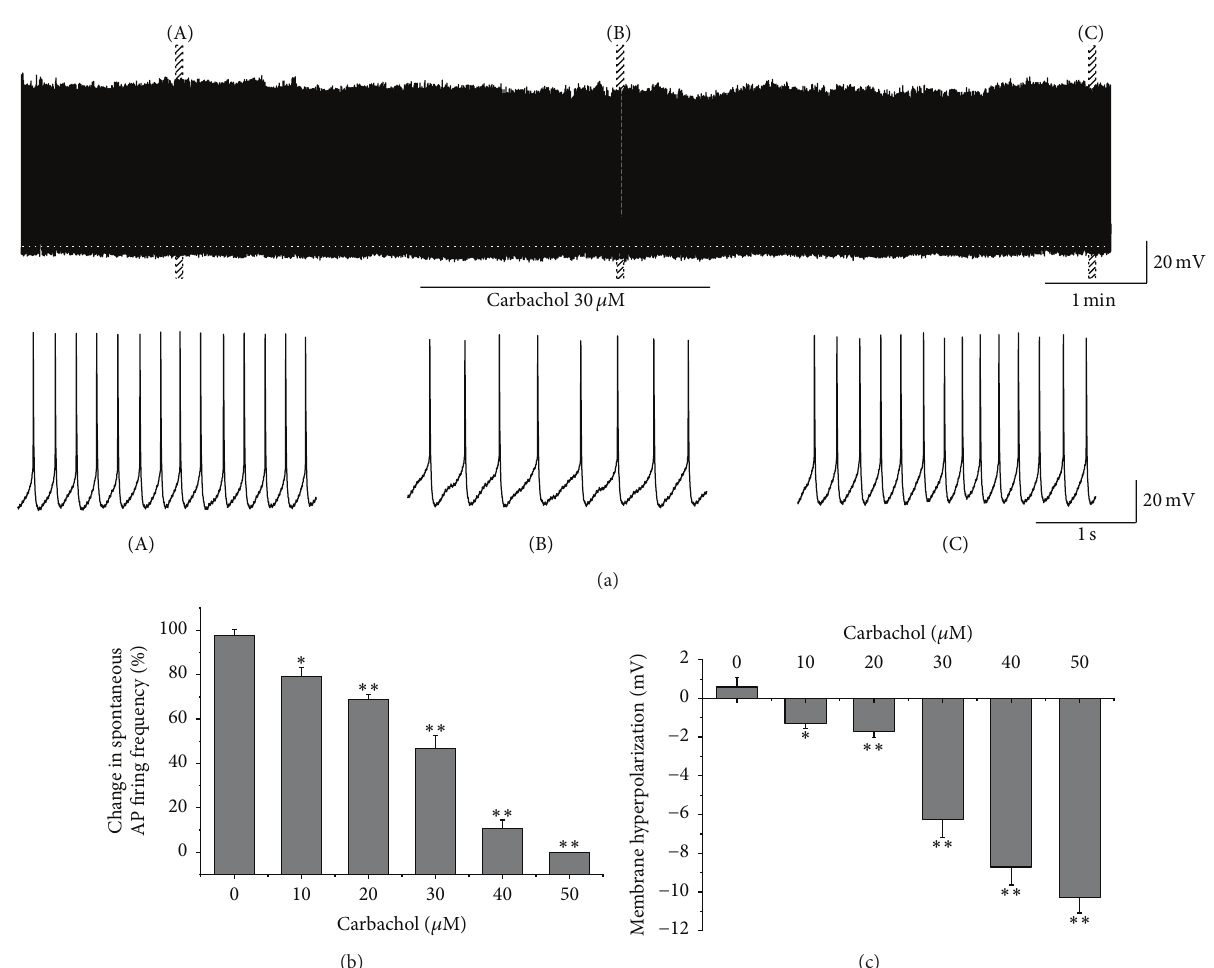
Figure 1: Carbachol produced a concentration-dependent decrease in the spontaneous AP firing frequency and induced a concentration- dependent membrane hyperpolarization in RA projection neurons. (a) A representative whole-cell recording showed the reversible effects of 30 𝜇 M carbachol on the spontaneous AP firing frequency and membrane hyperpolarization. (A, B, C) Traces from the box area in (a) in expanded time scales. (b) Inhibitory effects of carbachol on the spontaneous AP firing frequency. The number of neurons was 6, 6, 7, 11, 7, and 7 in 0, 10, 20, 30, 40, and 50 𝜇 M carbachol, respectively. (c) Hyperpolarization effects of carbachol on the resting membrane potential. The number of neurons was the same to (b). ∗ 𝑝 < 0.05 ; ∗∗ 𝑝 < 0.01 , paired 𝑡 test, as compared with 0 𝜇 M carbachol